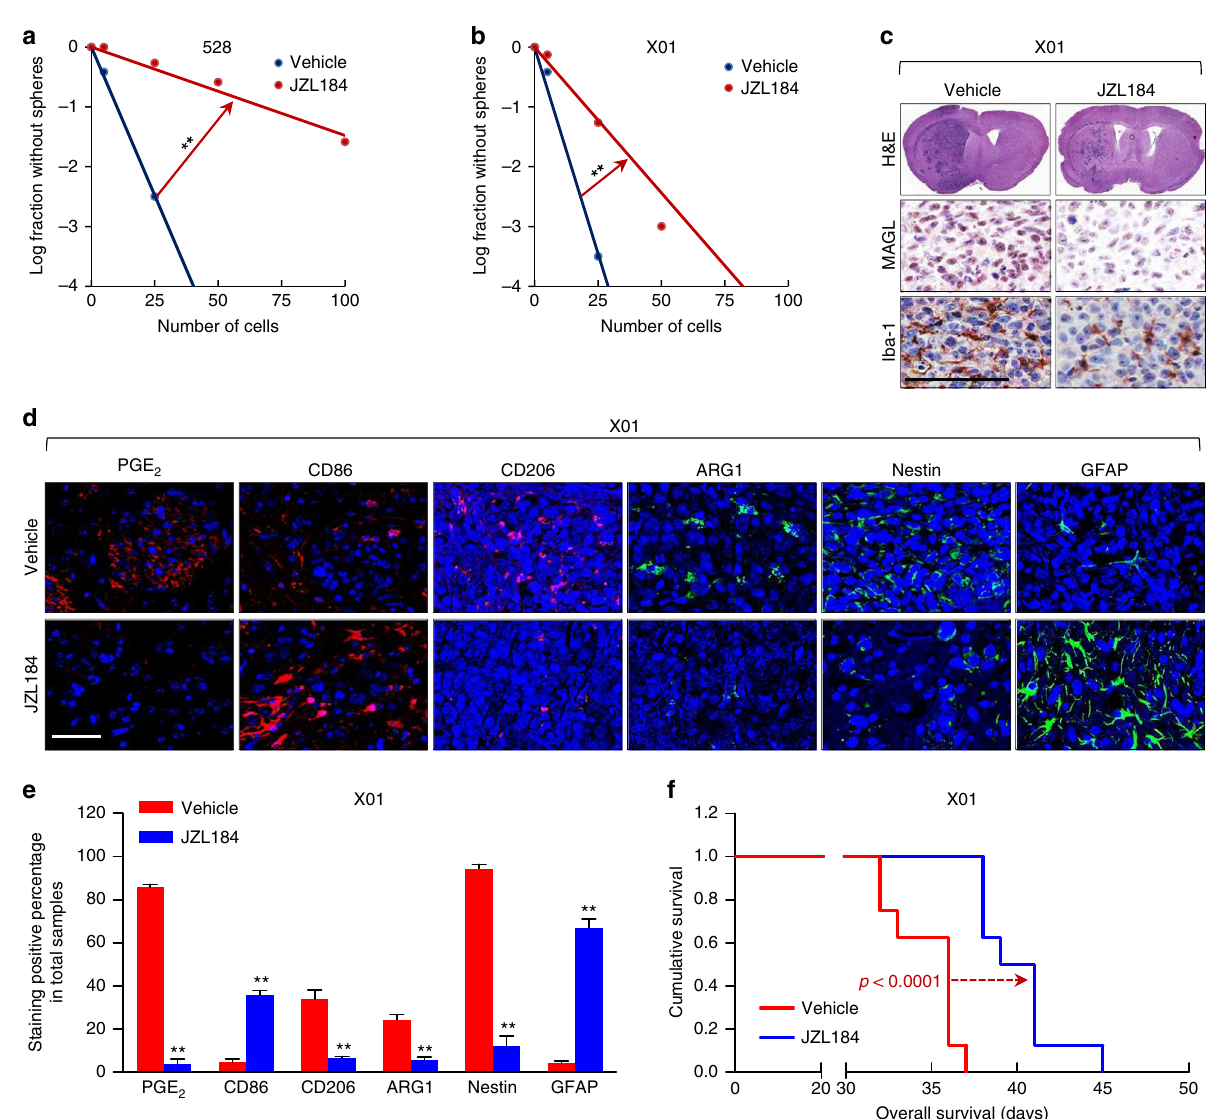
Fig. 7 JZL184 inhibits GSC self-renewal and tumorigenicity. a , b Limiting dilution assays (LDAs) performed using 528 cells (B) and X01 cells (C) treated with JZL184 (1 μ M). ( n = 24). c H&E staining of the whole brain and immunohistochemical (IHC) analysis of MAGL and Iba-1 in a JZL184-treated orthotopic xenograft mouse model. Scale bar, 100 µ m. The sample is extracted at 32 days after cell injection. d , e Representative IF images ( d ) and corresponding quanti fi cation ( e ) of PGE 2 , CD86, CD206, ARG1, Nestin, and GFAP in a JZL184-treated orthotopic xenograft mouse model. Scale bar, 50 µ m. All error bars represent mean ± SEM ( n = 3). * P < 0.05, ** P < 0.01, t -test. f Kaplan – Meier survival analysis of mice implanted with X01 cells treated with JZL184 or vehicle ( n = 8; 2.5 × 10 4 cells injected per mouse, log-rank test). Median survival of the mice treated with vehicle, or JZL184 was 36 days, and 40 days,